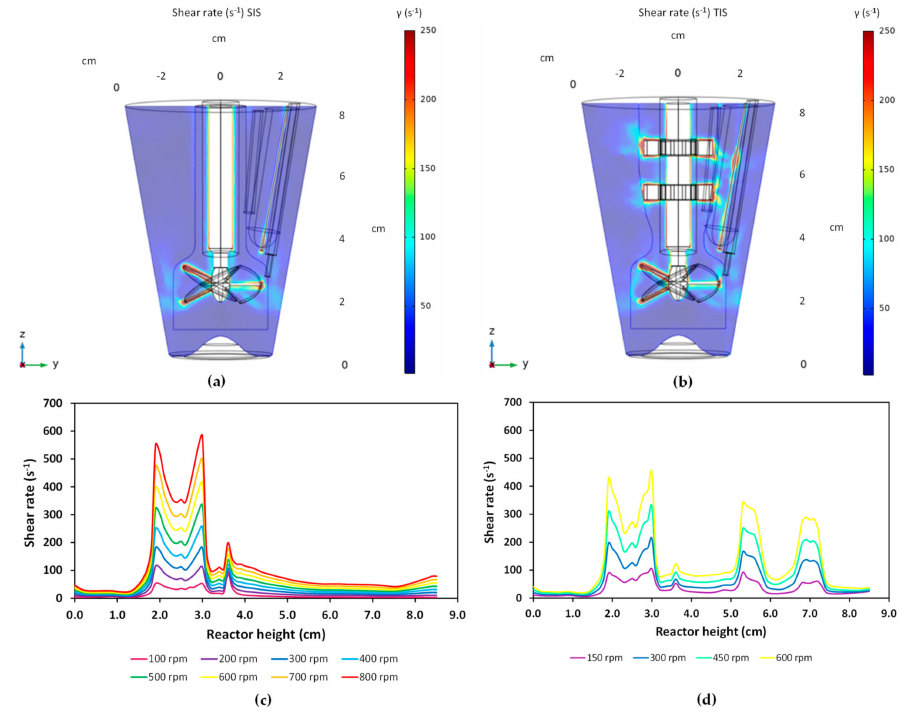
Figure A2. Shear rate γ in the SIS and TIS: ( a ) shear rate in the SIS; ( b ) shear rate in the TIS. The shown data correspond to an agitation rate of 400 rpm. ( d ) Mean shear rate along the reactor height (slice plot) in the SIS for different agitation rates; ( d ) mean shear rate along the reactor height (slice plot) in the TIS for different agitation rates. In ( c , d ), the shear rate was averaged across the diameter in steps of one millimeter along the reactor height.